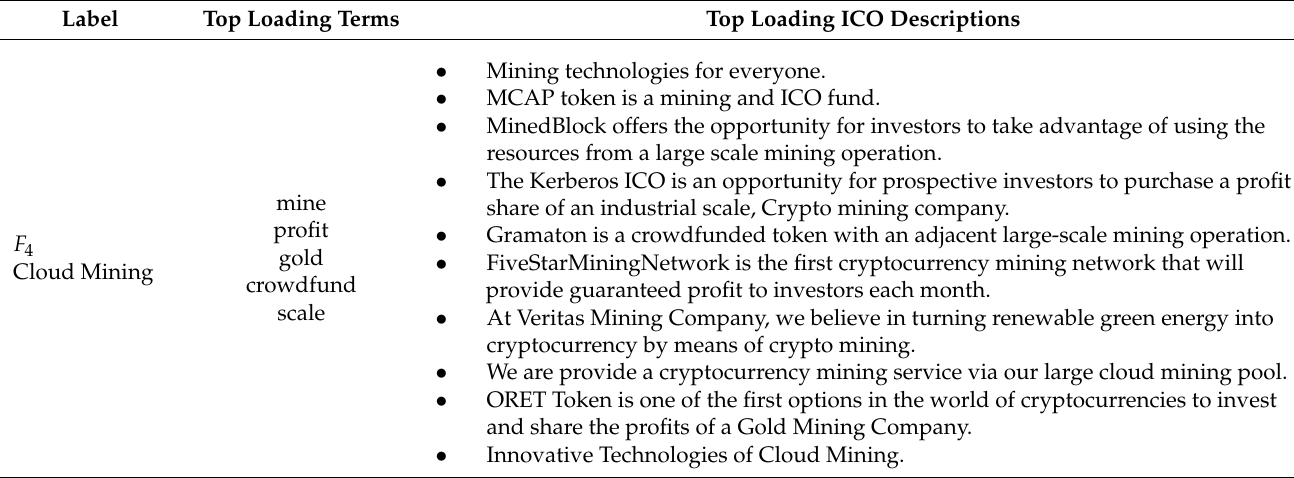
Table A4. Cloud Mining.